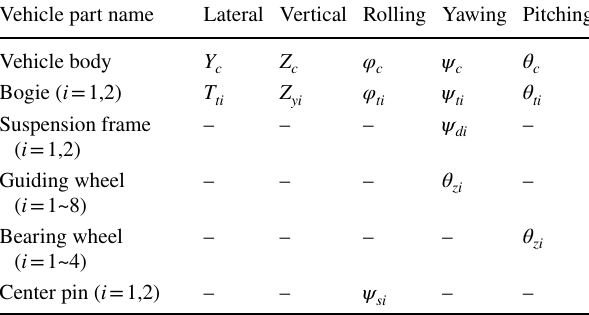
Fig. 2 The first-order frequency and vibration mode of STM bridge